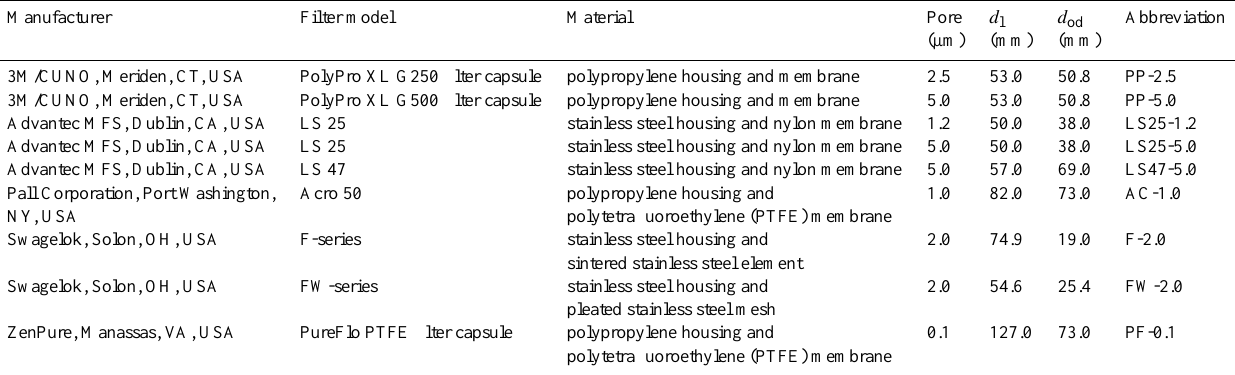
Table 2. Candidate filters and filter materials considered in this study, and their key characteristics including pore size (pore), length ( d l ) and outer diameter ( d od )